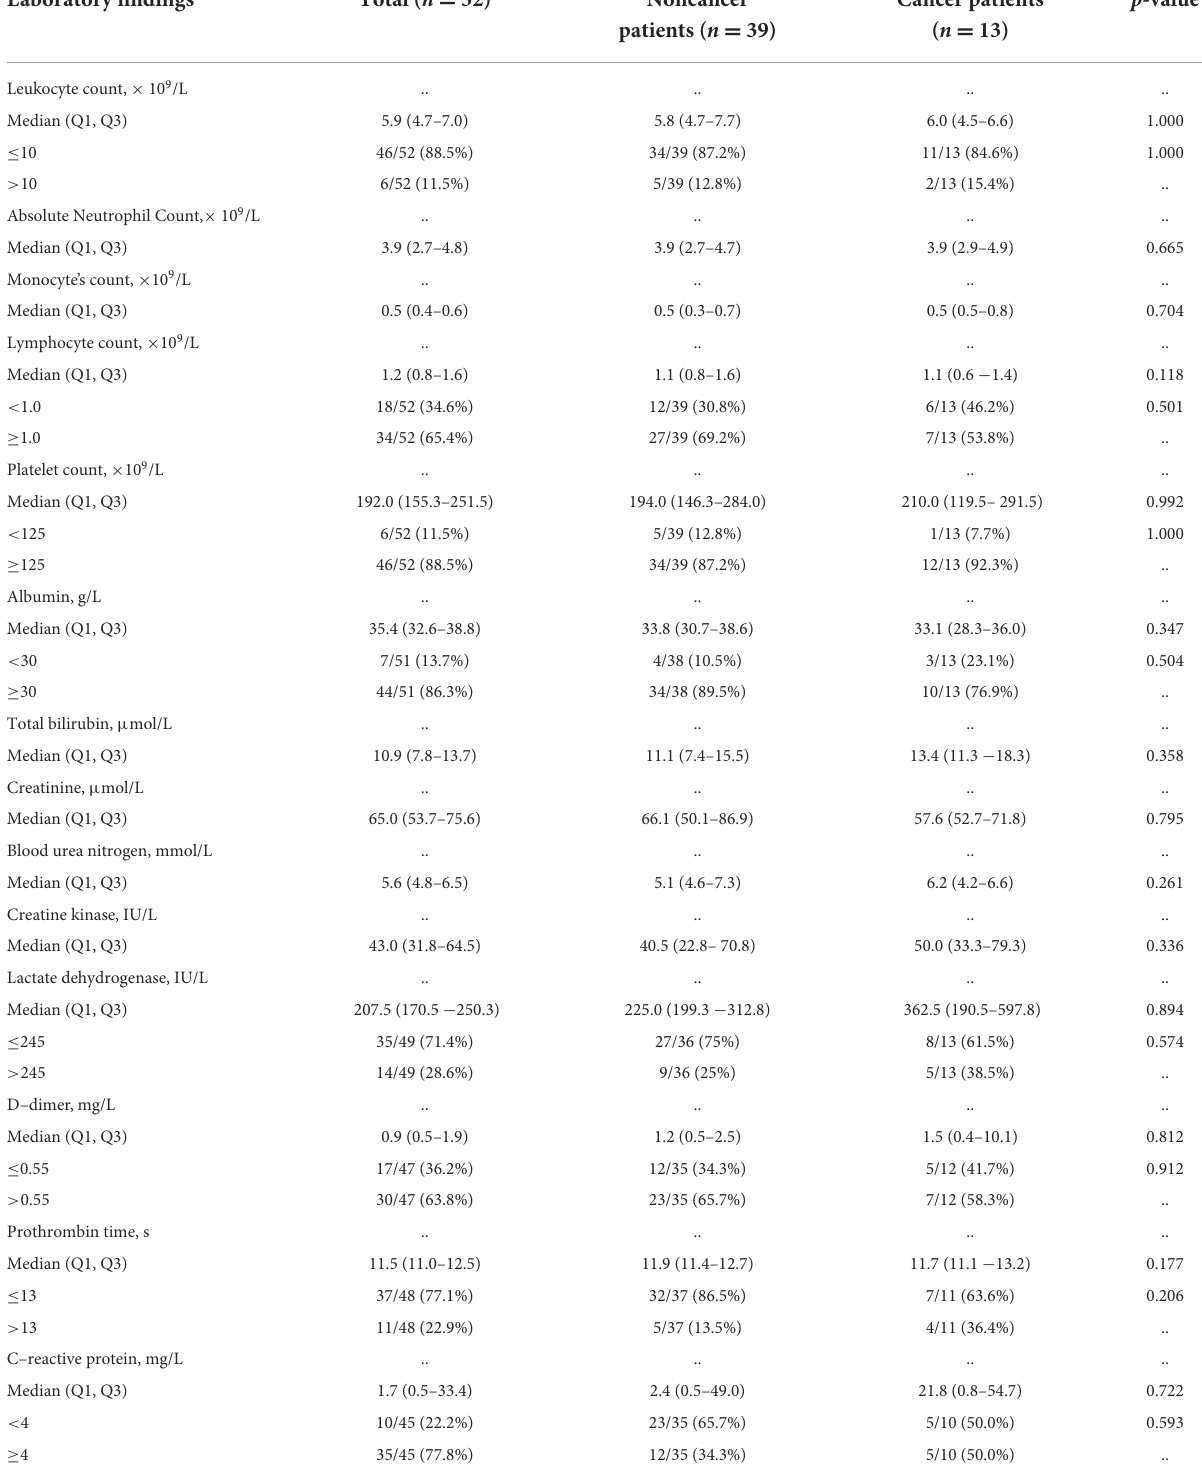
TABLE 3 Laboratory findings for COVID-19 patients with and without cancer on